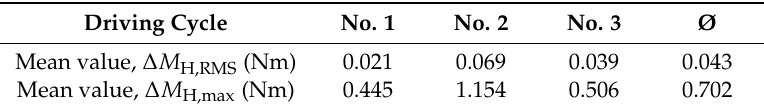
Table 1. Mean values of root mean square and maximum deviations of driver steering torques, M H , between conventional steering assistance systems and e 2 ‐ Lenk.